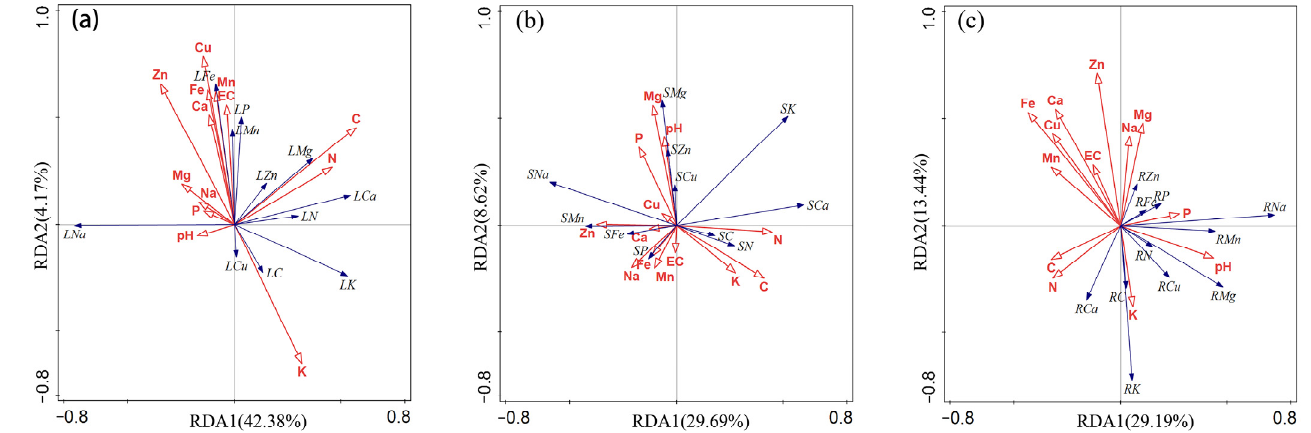
Figure 4. RDA analysis of the soil mineral elements and soil salt vs. plant leaf ( a ), stem ( b ) and root ( c ) mineral elements. Table 3. Summary of the general linear models for the effects of salt tolerance type, soil salinity property and soil mineral element factors on the concentrations of mineral elements in